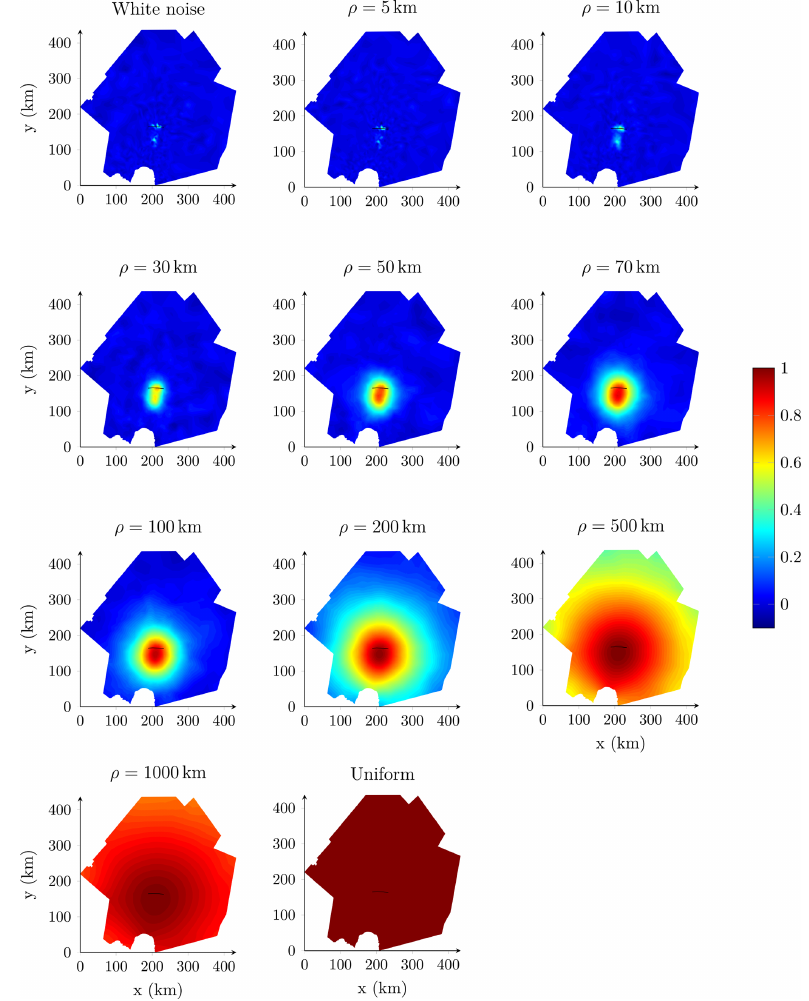
Figure 12. Sensitivity map (visual representation of the coefficient of correlation) for mass flux across fluxgate 3 (see Fig. 5) for different parameter